Question: Which kind of chart has been used to present this data?
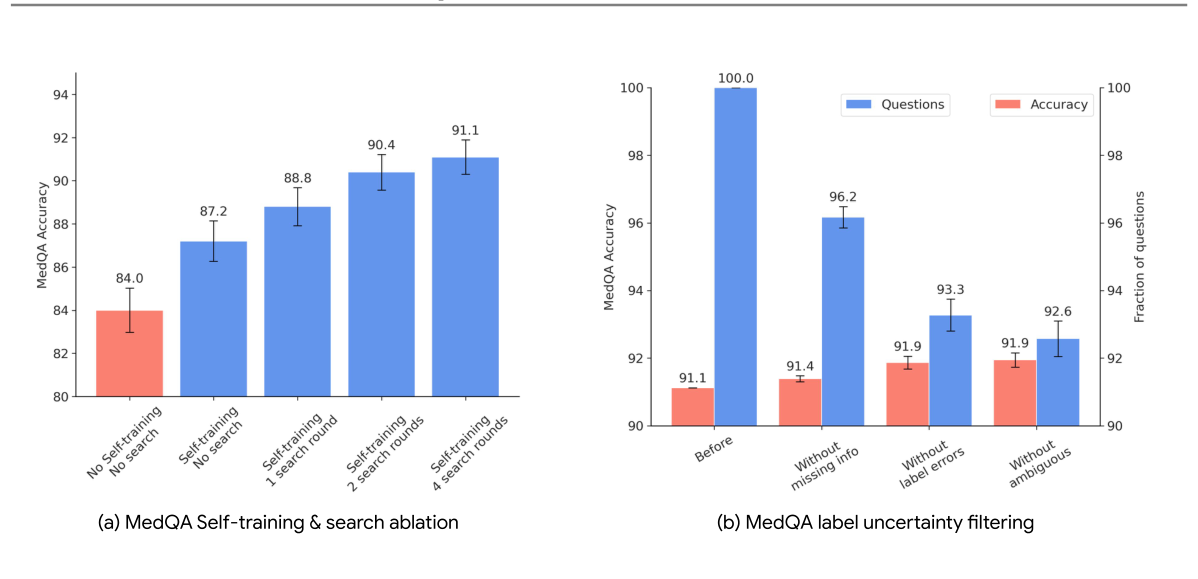
Answer: bar